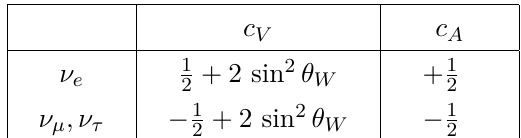
Table 1 . Values of the SM effective couplings in neutrino-electron scattering. For antineutrinos the vector couplings are the same, while the axial ones change sign, c A → − c A